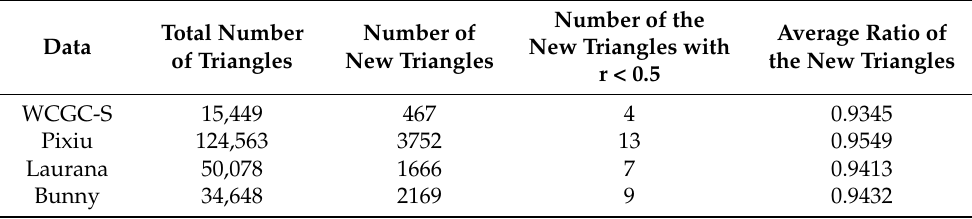
Figure 13. Comparative CloudCompare results. (a), (d), and (g) are the comparison between the original model without holes and the model filled by VCG. (b), (e), and (h) show the comparison between the model filled by MeshFix and the original model. (c), (f), and (i) indicate the comparison between the model filled by LIMOFilling and the original model.